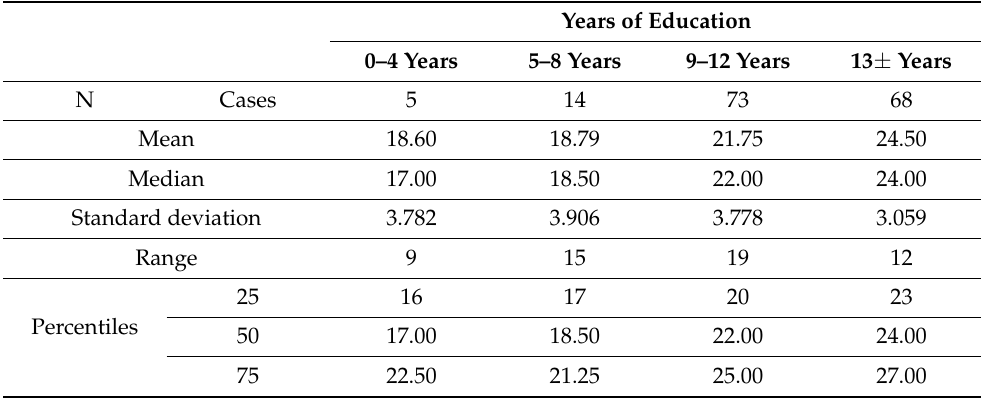
Table 2. The 25th percentiles are the cutoff points for each educational level (to decrease the number of false-positive